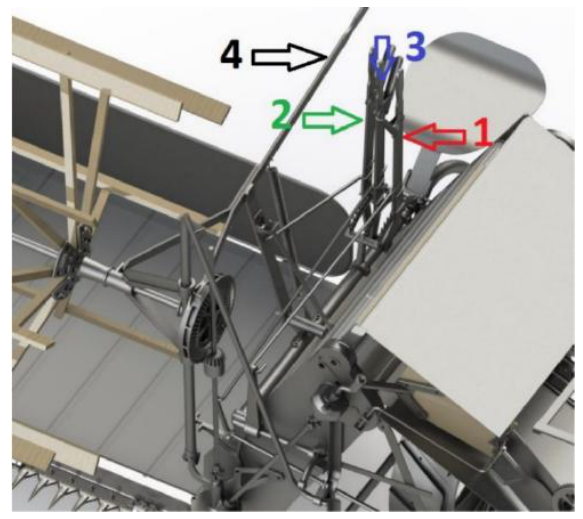
Figure 32. Adjustment levers.